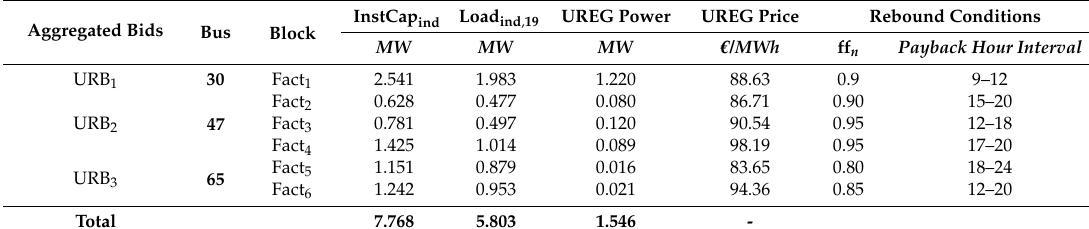
Table 8. Industrial area flexibility at hour 19.